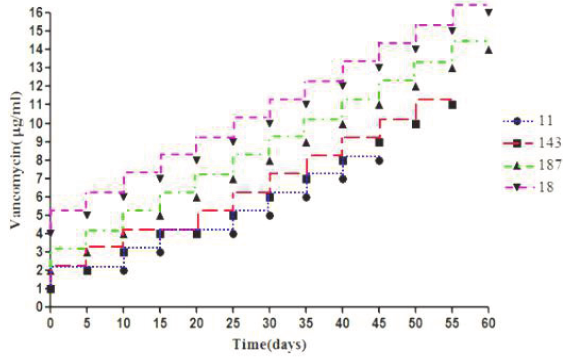
Figure 1: The induction process of four parental strains 11, 143, 187 and 18 with an initial vacomycin concentration of 1 μ g/ml, 1 μ g/ml, 2 μ g/ml and 4 μ g/ml respectively. Each round of selection lasted for 5 days with an increase of 1 μ g/ml vancomycin concentration